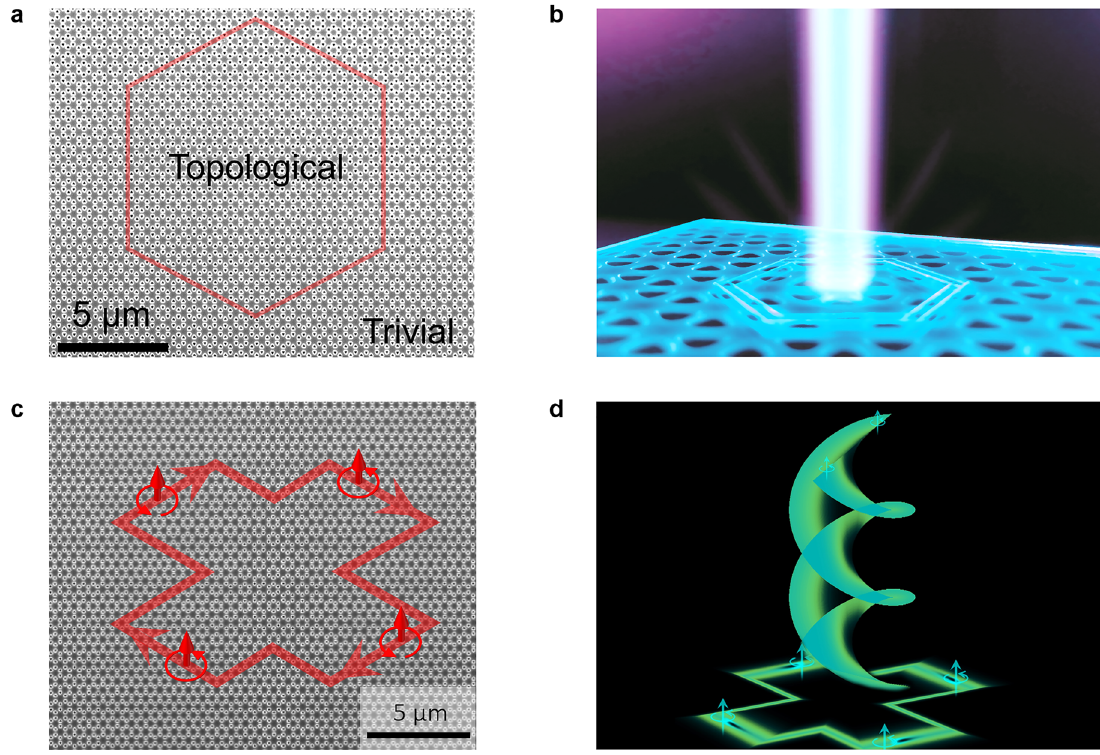
Figure 8: Topological bulk laser and topological vortex laser. a SEM image of a topological bulk laser based on band-inversion-induced re fl ection. b Schematic of a topological bulk laser with vertical emission. c SEM image of a topological vortex laser based on spin-momentum locked edge modes. d Schematic of a topological vortex laser with vortex emission. Figure adapted [52,